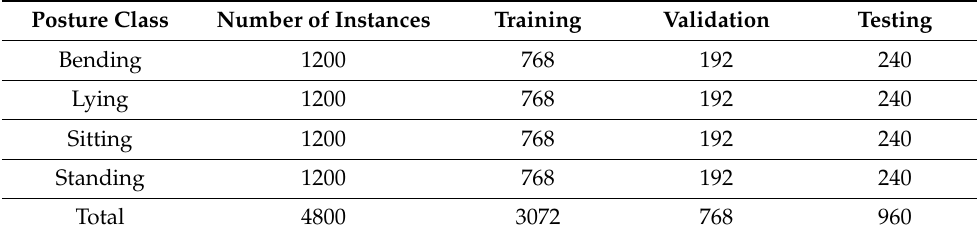
Table 1. Distribution over the posture of the Data